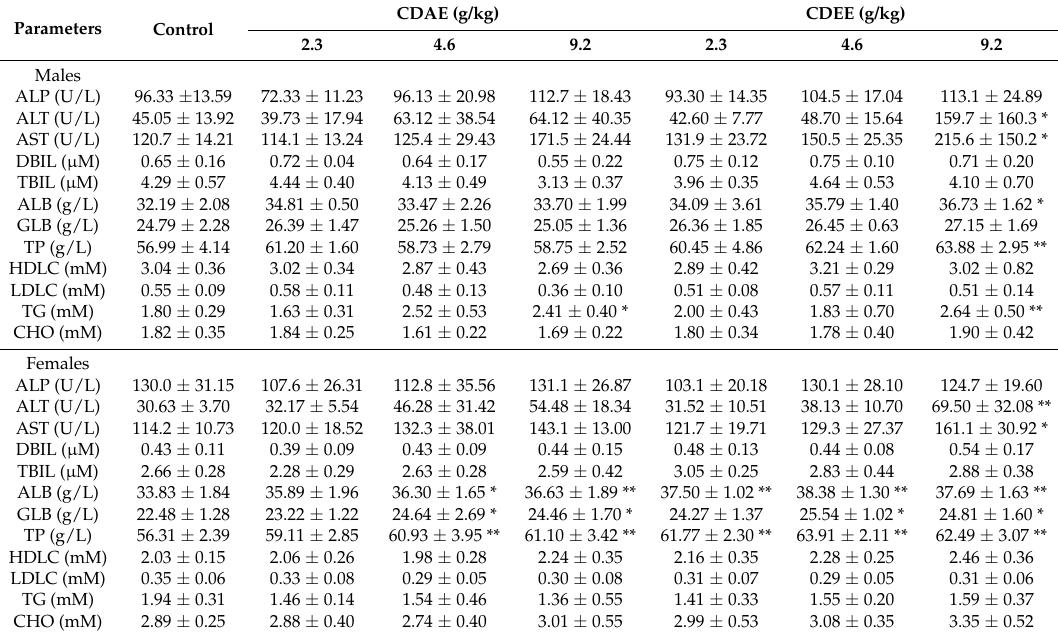
Table 2. Effects of oral administration of Cortex Dictamni aqueous extract (CDAE) and Cortex Dictamni ethanol extract (CDEE) on the biochemical parameters in mice.